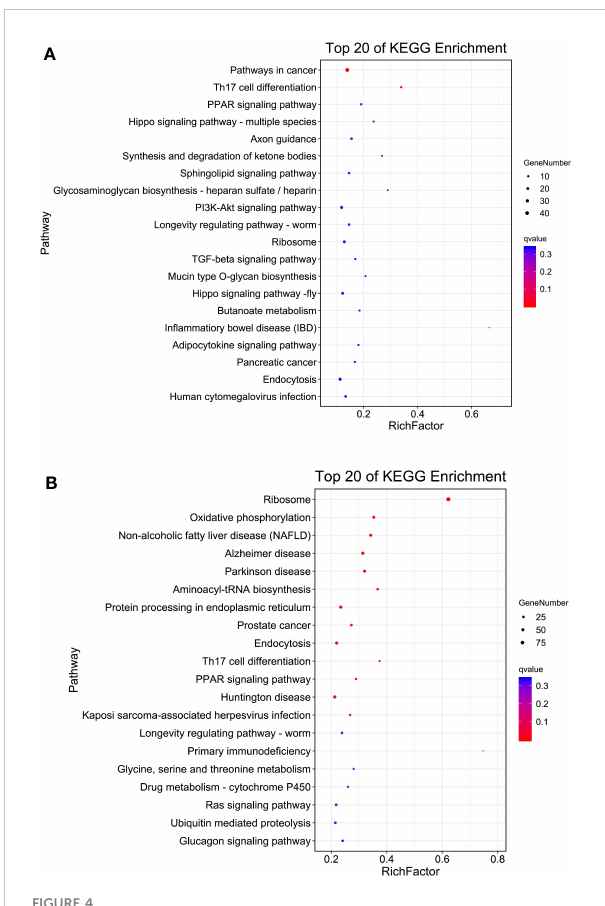
FIGURE 4 KEGG pathway enrichment analysis of DEGs in each comparison group. (A) S4383-0-G vs R4345-0-G, (B) S4383-6-G vs R4345-6-G. The y-axis belongs to speci fi c pathway, and the x-axis belongs to enrichment factor. The size and colors of the dots represent the number of genes and q values, respectively (The dots with larger- size indicated a higher number of genes in the